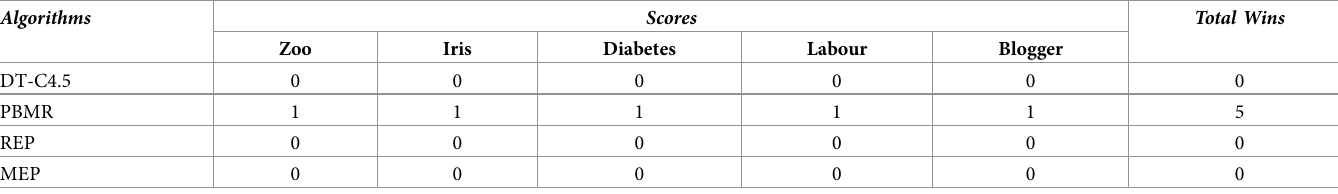
Table 9. Recall scores of PBMR, REP, and MEP. Algorithms